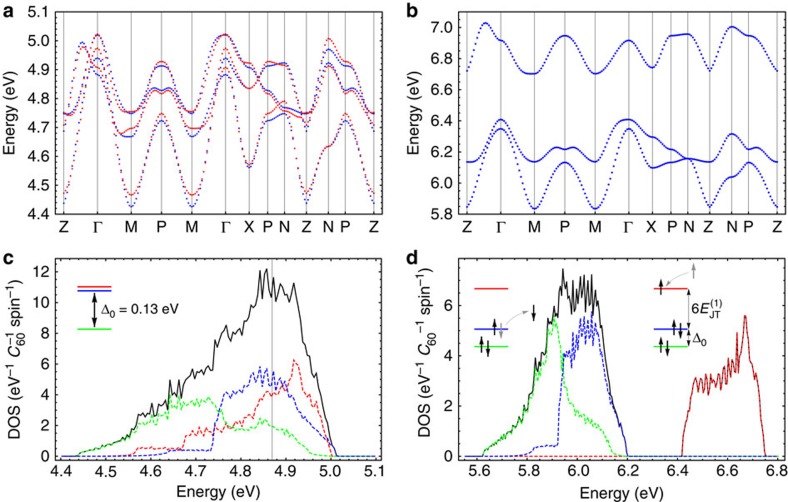
LUMO band and density of states.(a) LUMO band dispersion and (c) corresponding density of states of K4C60 calculated by DFT (generalized gradient approximation) for experimental structure. (b) Dispersion of single-particle excitations and (d) the corresponding density of states corresponding to the orbitally disproportionated ground state at U||=0.5 eV and without hybridization between the occupied and empty band orbitals. The blue dots in a and c show the tight-binding simulation, and red dots in (a) the DFT calculations. The black line in c and d corresponds to a full DOS, whereas the coloured lines the orbitally projected DOS.